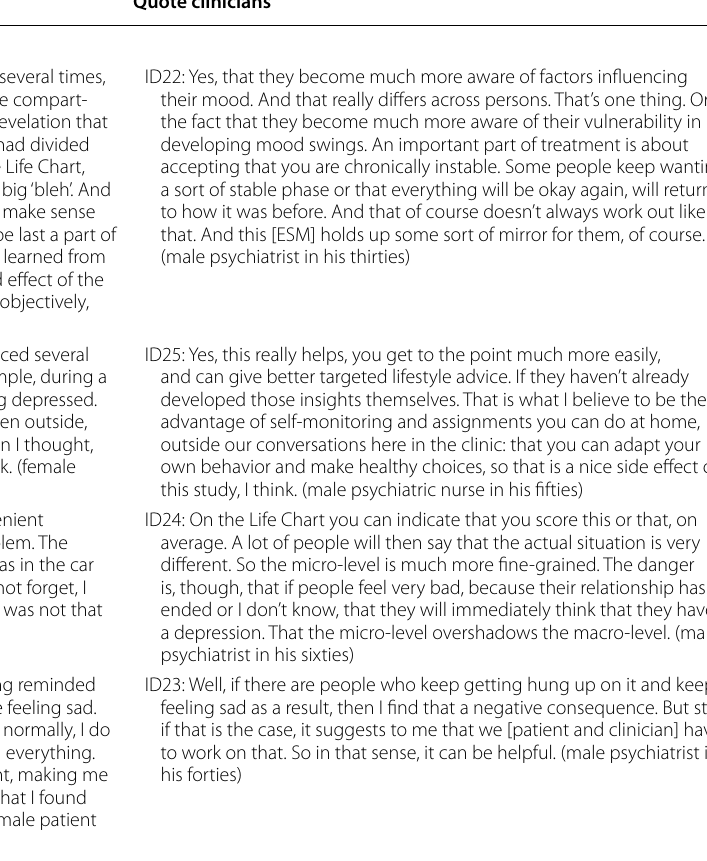
Table 2 Quotes related to theme 1 (effects of monitoring) and theme 2 (effects of weekly questionnaires and alerts) Quote patients Quote clinicians Theme 1: effects of